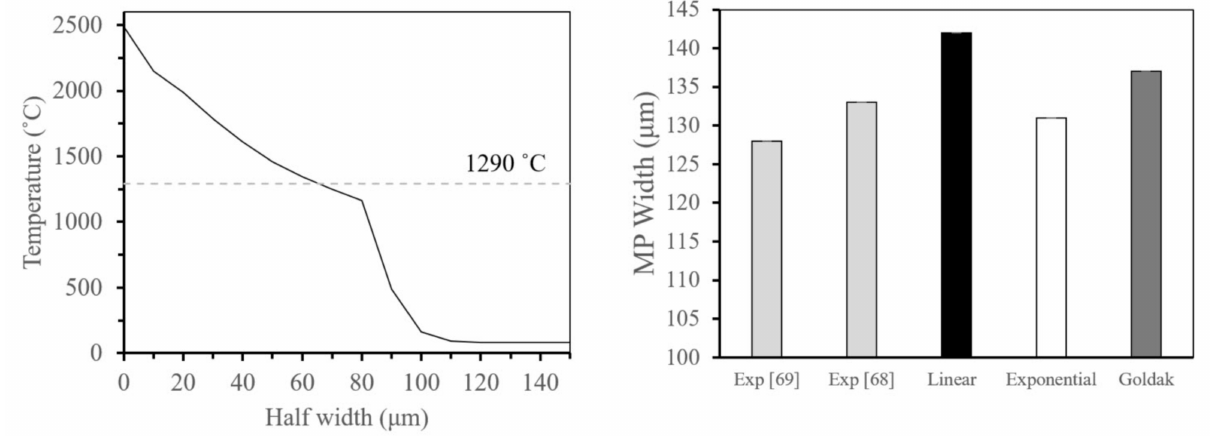
Figure 8. Validation of predicted melt pool